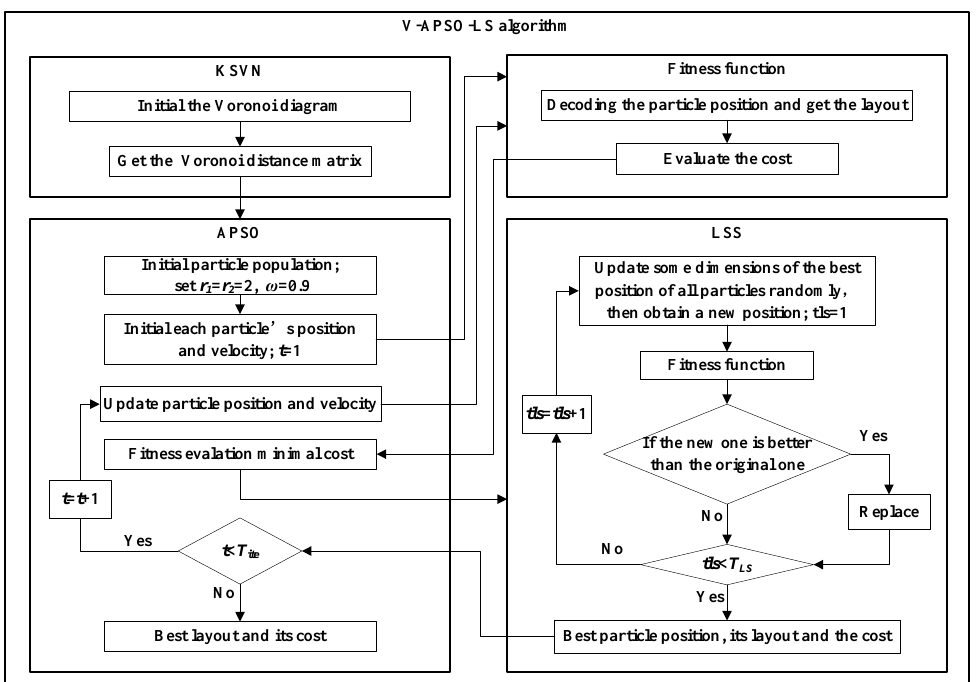
Figure 8. Optimization framework of V-APSO-LS.